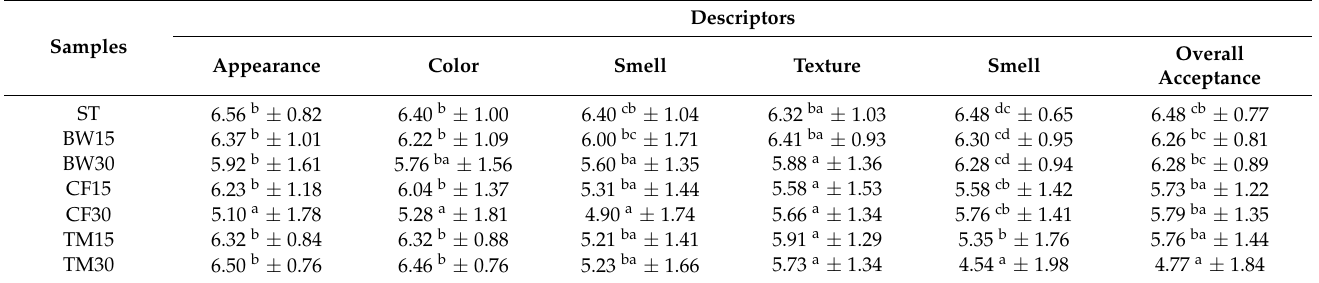
Table 5. Consumer acceptance of